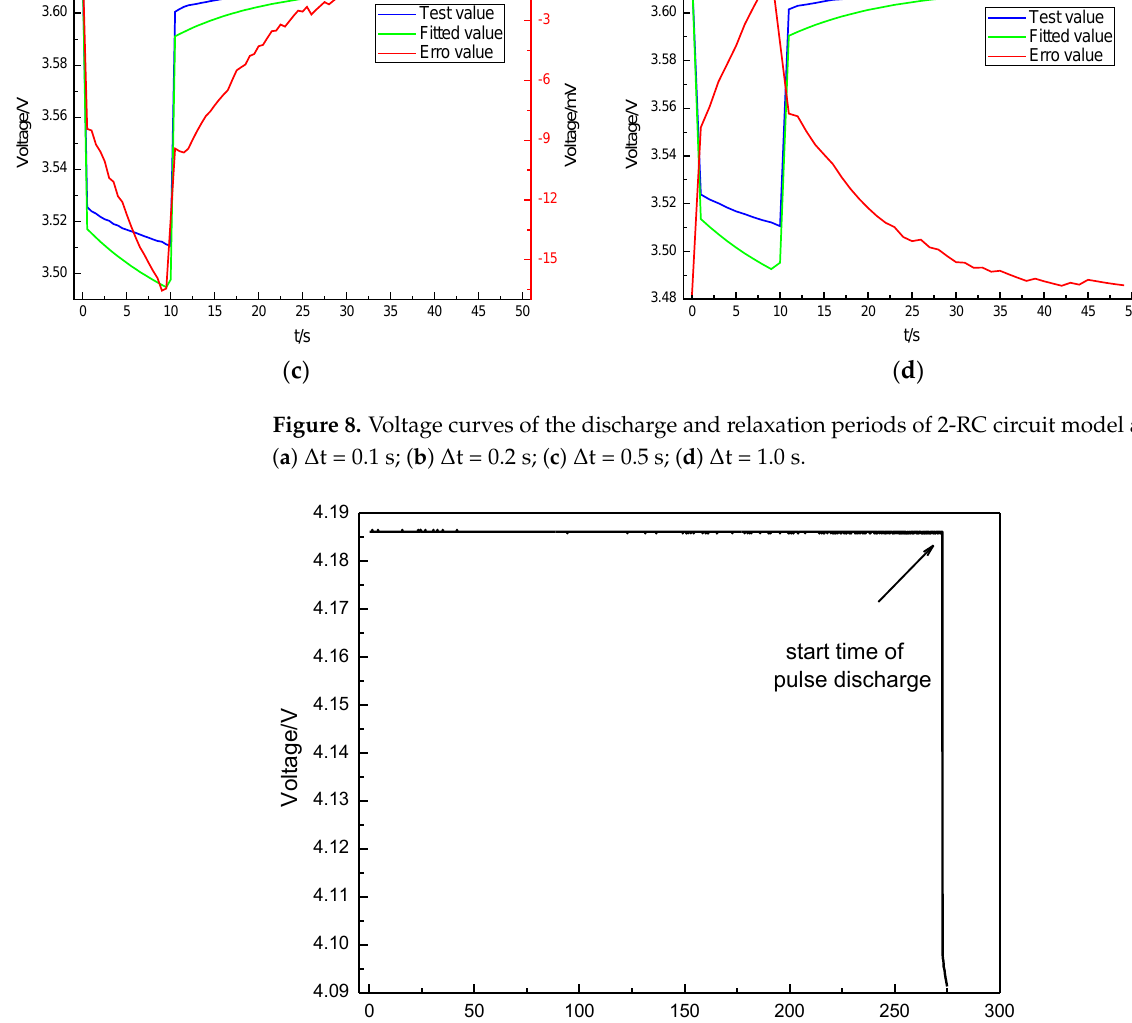
Figure 9. Voltage over time of the rest period before the first pulse discharge.